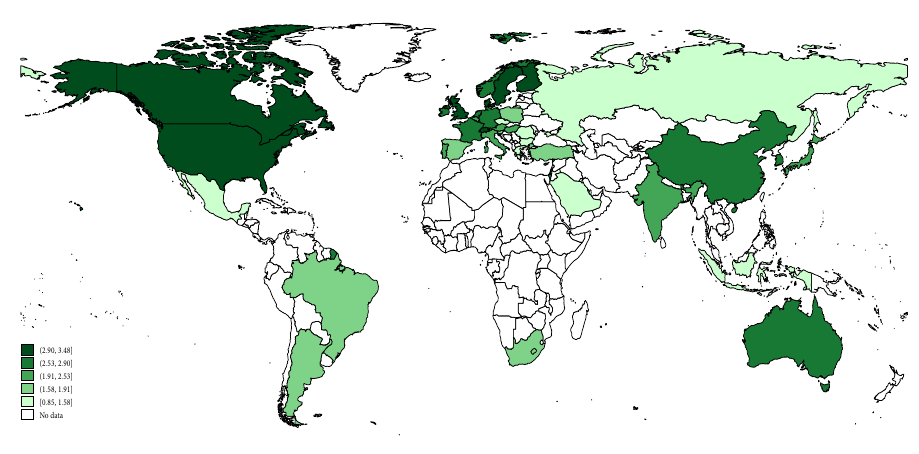
Figure 3. Inputs to Innovation indicator